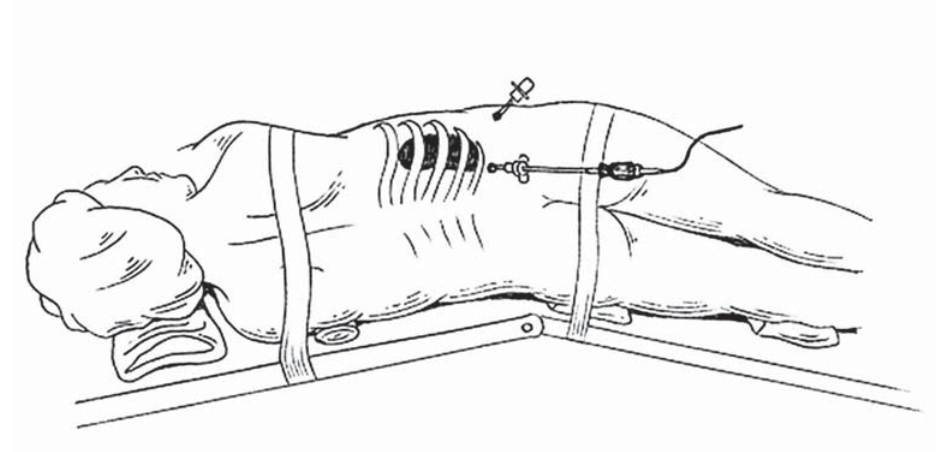
Figure 1 – Patient position in operative table for retroperitoneoscopic renal